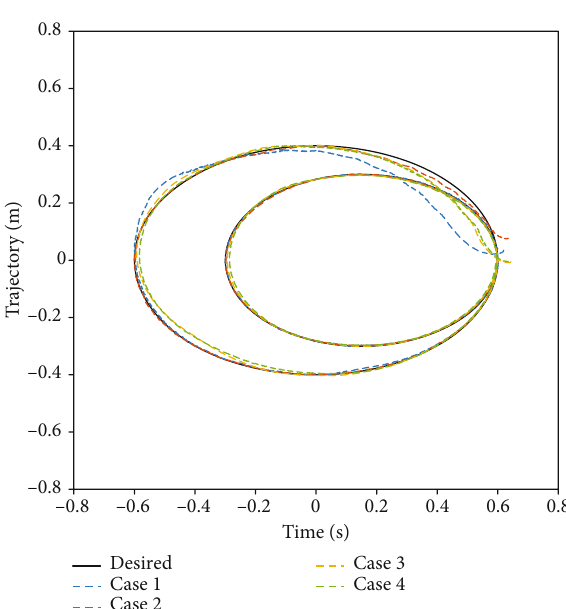
Figure 6: Experimental result: tracking error of simulator in y